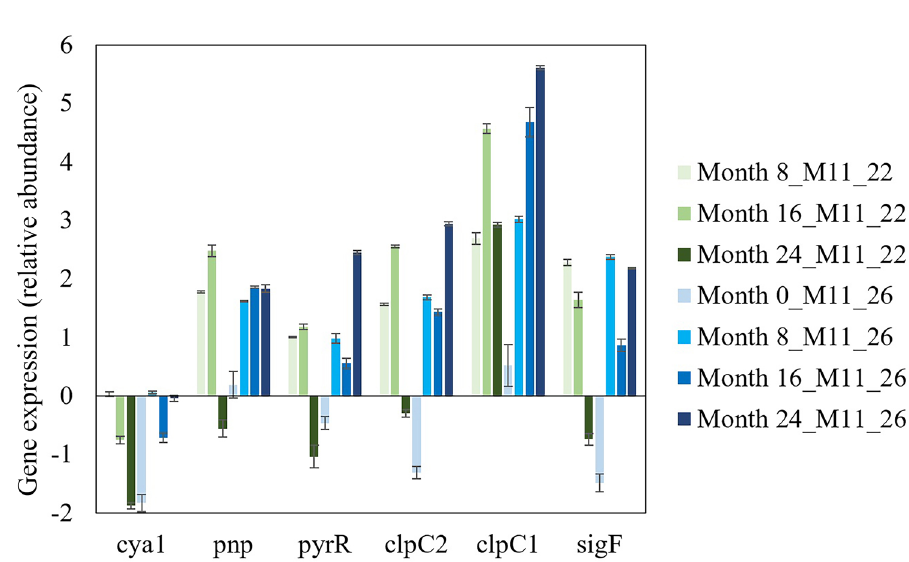
Figure 2. The gene expression results for six genes for M11_22 and M11_26 for Months 0–24. The values represent the relative abundance of target genes based on rnp B, which was used as reference gene. These results were normalized against Month 0_M11_22 to determine if temperature has caused a change in gene expression. Each test was done in three